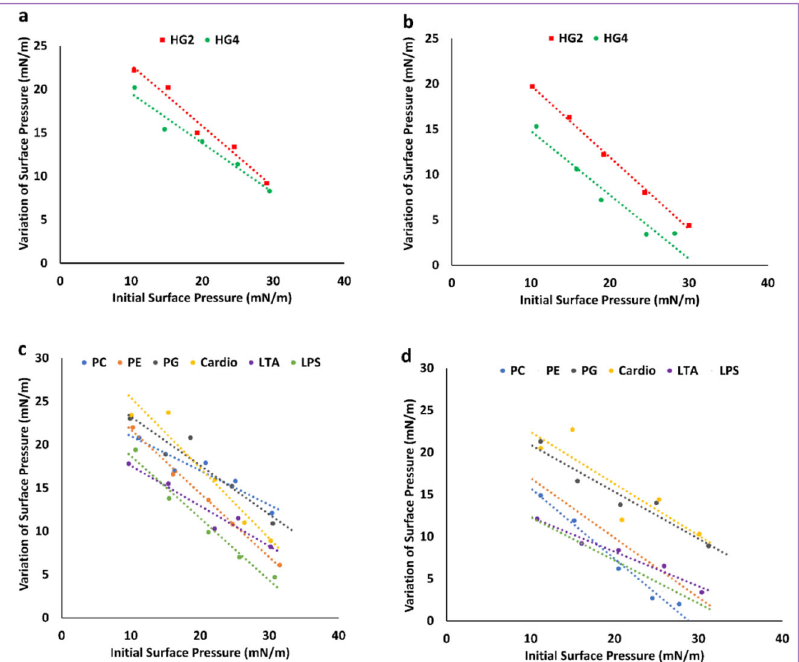
Fig. 6 Peptide – lipid interaction and insertion measurements. Interaction of HG2 and HG4 (at 1 µg/mL fi nal concentration) with lipids (either total lipid extracts or pure lipids) was measured using lipid monolayers. a interaction HG2 and HG4 with total MRSA lipid extract. b interaction HG2 and HG4 with total lipid extract from human erythrocytes. c interaction of HG2 with pure lipids and d interaction of HG4 with pure lipids. 1-palmitoyl-2-oleoyl- sn -glycero-3-phospho-(1 ’ -rac-glycerol) (PG), 1-palmitoyl-2-oleoyl- sn -glycero-3-phosphoethanolamine (PE), Cardiolipin (Cardio), Lipoteichoic acid (LTA) from S. aureus , Lipopolysaccharide (LPS) from E. coli and (1-palmitoyl-2-oleoyl-glycero-3-phosphocholine